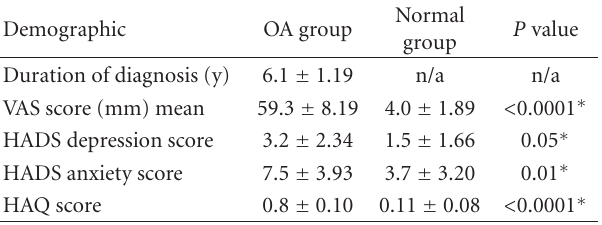
Table 2: Participant-reported outcome measures (PROMs). Data for duration of diagnosis, VAS in the hand OA versus the control group, Hospital Anxiety and Depression Scale (HADs) with subscales for anxiety and depression, and Health Assessment Questionnaire (HAQ) scores are shown with mean ± SD. P values are shown for group comparisons between hand OA and healthy control participants. Di ff erences between groups were analysed using the Mann-Whitney U -test with significance considered at P ≤ 0 .